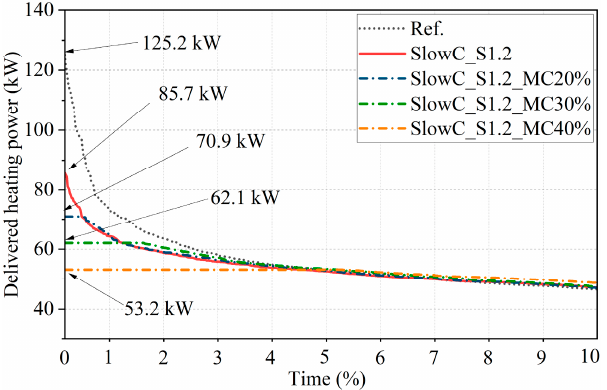
Figure 13. Heating season (14 October–7 May) duration of delivered heating power. Table 5 lists the duration proportions of different delivered heating power ranges of the reference case and peak shaving cases with and without mass flow cutting during the heating season. For the case SlowC_S1.2, it indicates that because of the storage, the duration proportion of the delivered heating power from 20 kW to 60 kW is 3.4 percentage